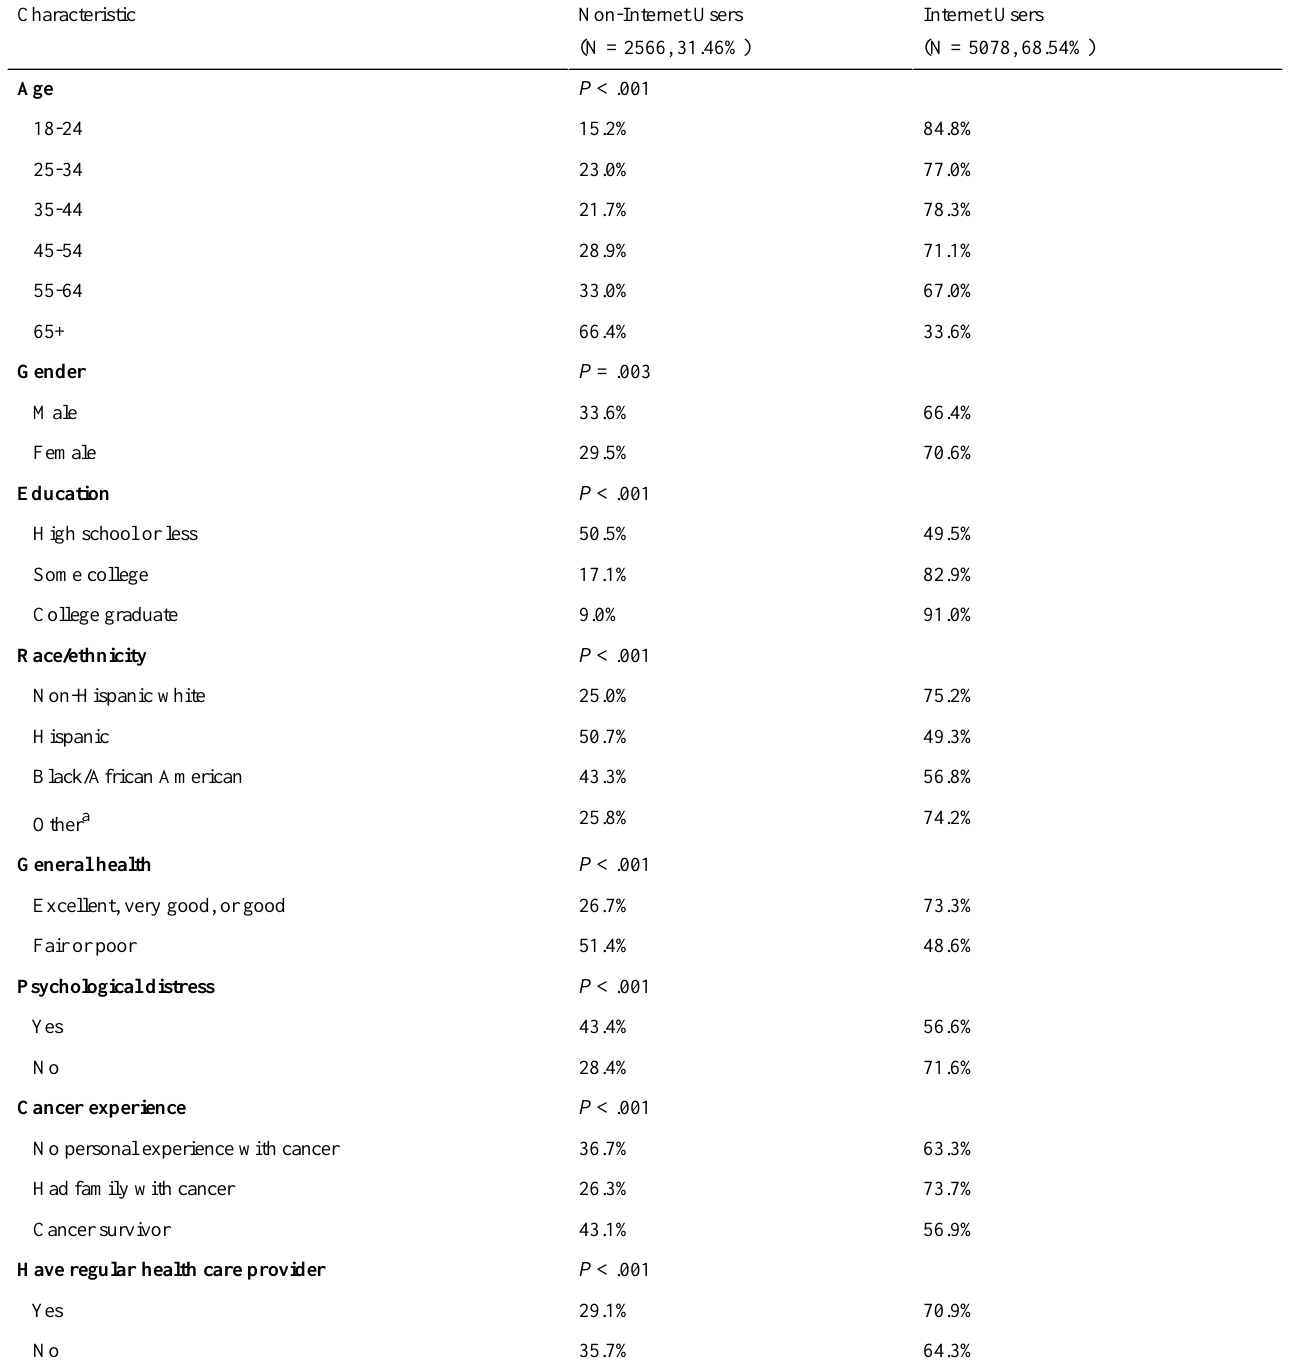
Table 1. Weighted sample characteristics: proportion of non-Internet and Internet users in each